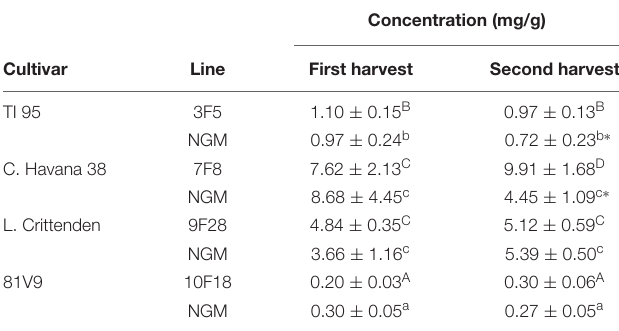
TABLE 1 | The concentration of nicotine (mg/g) in fresh tobacco leaves from the field trial.